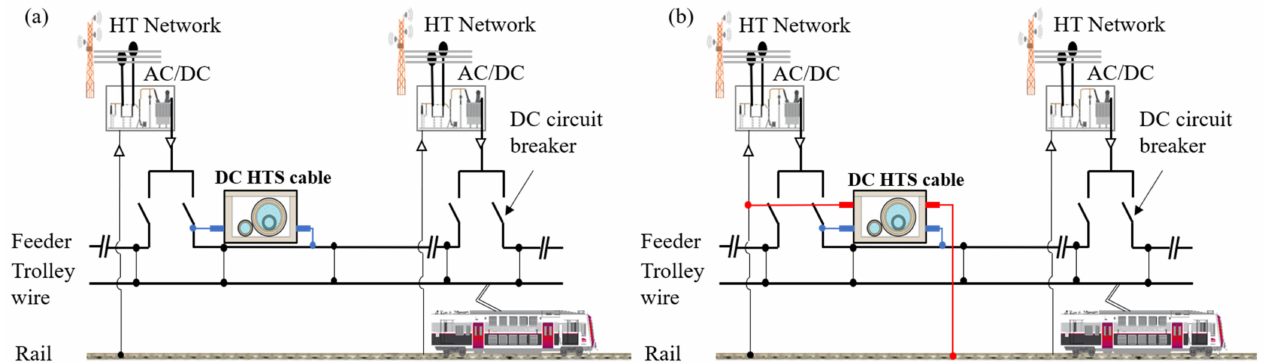
Figure 3. Typical diagram of the introduction of a DC superconducting cable; ( a ) unipolar cable, ( b ) bipolar